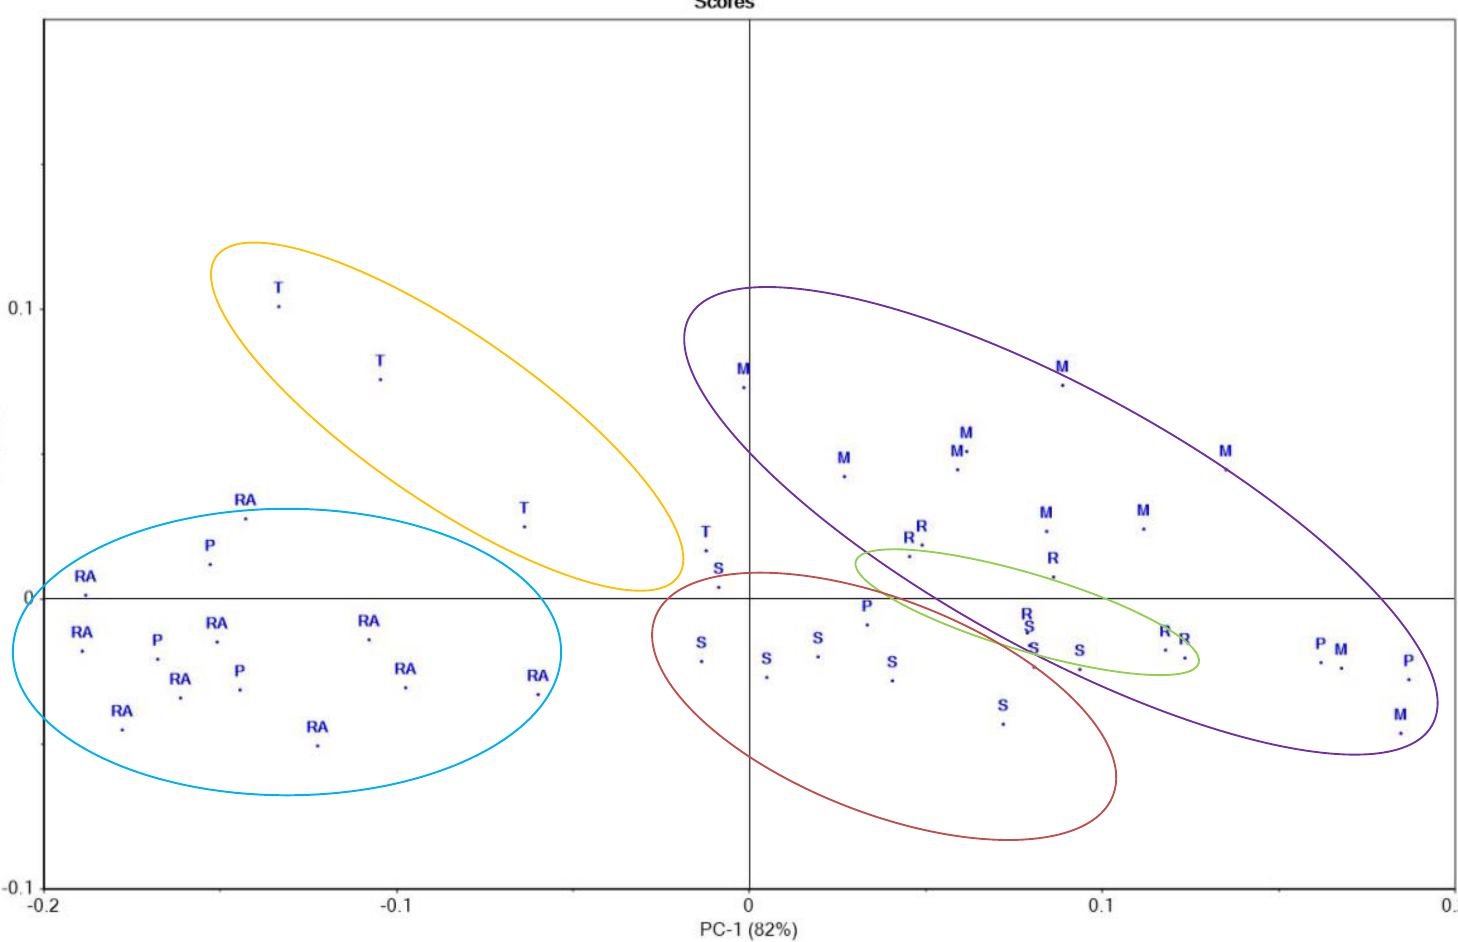
Figure 1. Principal component analysis—scores: RA—rape, T—thyme, P—polyfloral, S—sunflower, M—mint, and R—raspberry honey. Blue ellipse—rape honey group, yellow ellipse—thyme honey group, red ellipse—sunflower honey group, green ellipse—raspberry honey group, and purple ellipse—mint honey group.